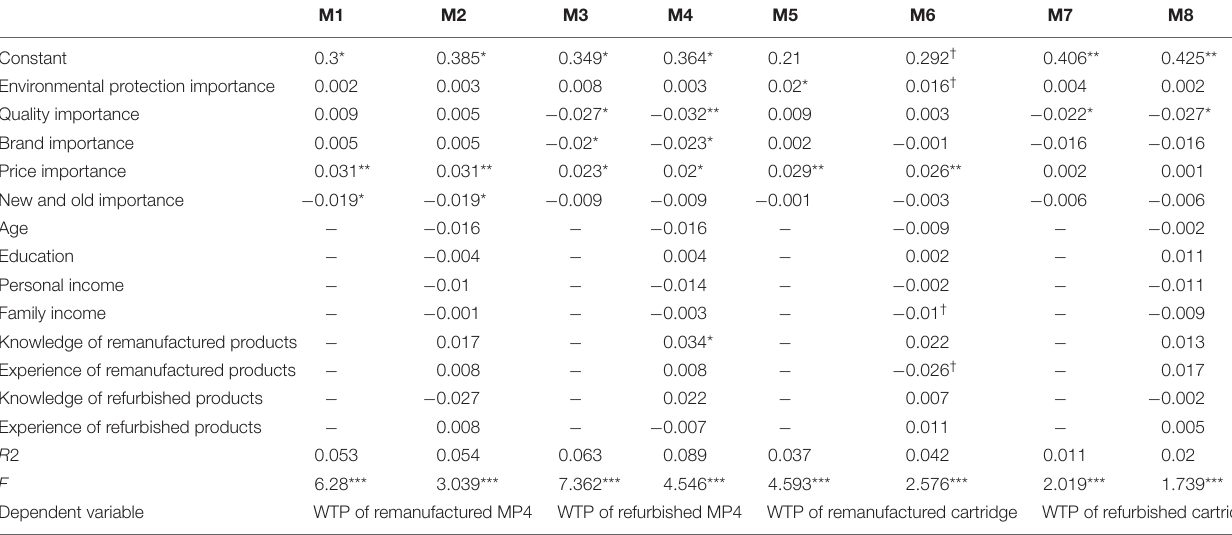
TABLE 9 | Regression coefficient (Remanufactured MP4 willingness to pay).